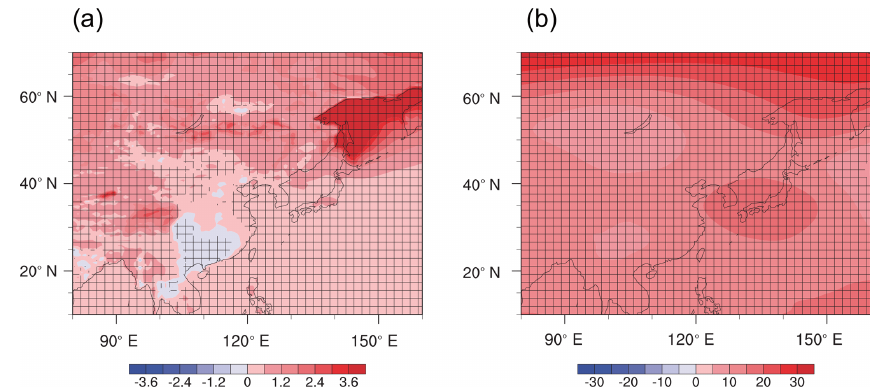
Figure 3. Composite differences of winter-mean (a) surface air temperature (shading, ◦ ) and (b) 500hPa geopotential height (shading, meters) between the All-Hist runs and Nat-Hist runs, during 1960–2012. The plus signs denote where the composite differences are significant at the 95% confidence level based on a two-sided Student’s t test.